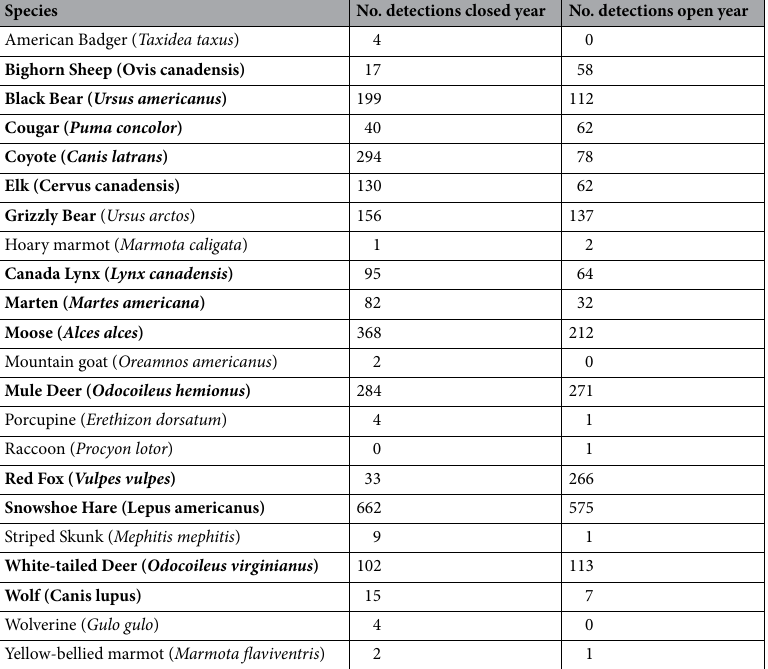
Table 2. The number of independent detections (> 1 h separation of photos at a given camera) of mid- to large-sized mammals (> 1 kg in body mass) at remote cameras located in Glacier National Park in years closed and open to recreation. Numbers are sums across all cameras. Bolded species had sufficient detections to be included in the occupancy and activity overlap analyses.